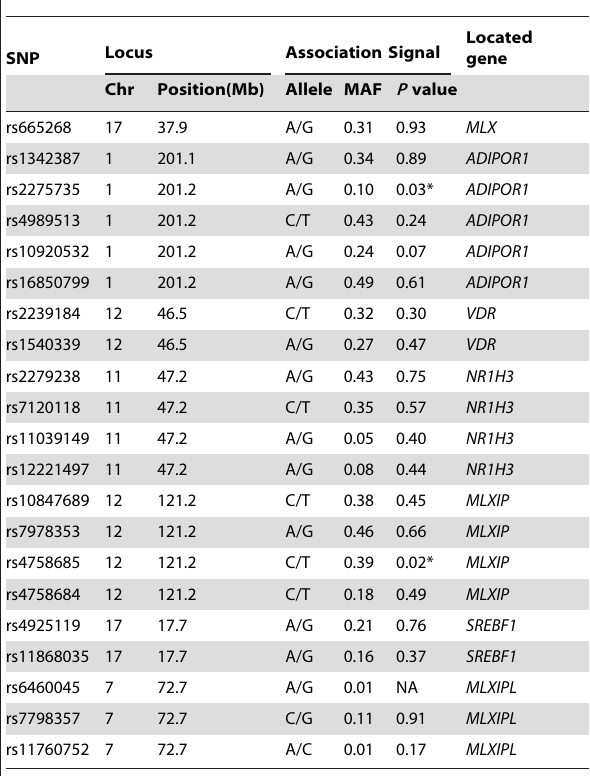
Table 1. The characteristics of the clinical data in comparisons between control and CHD groups.